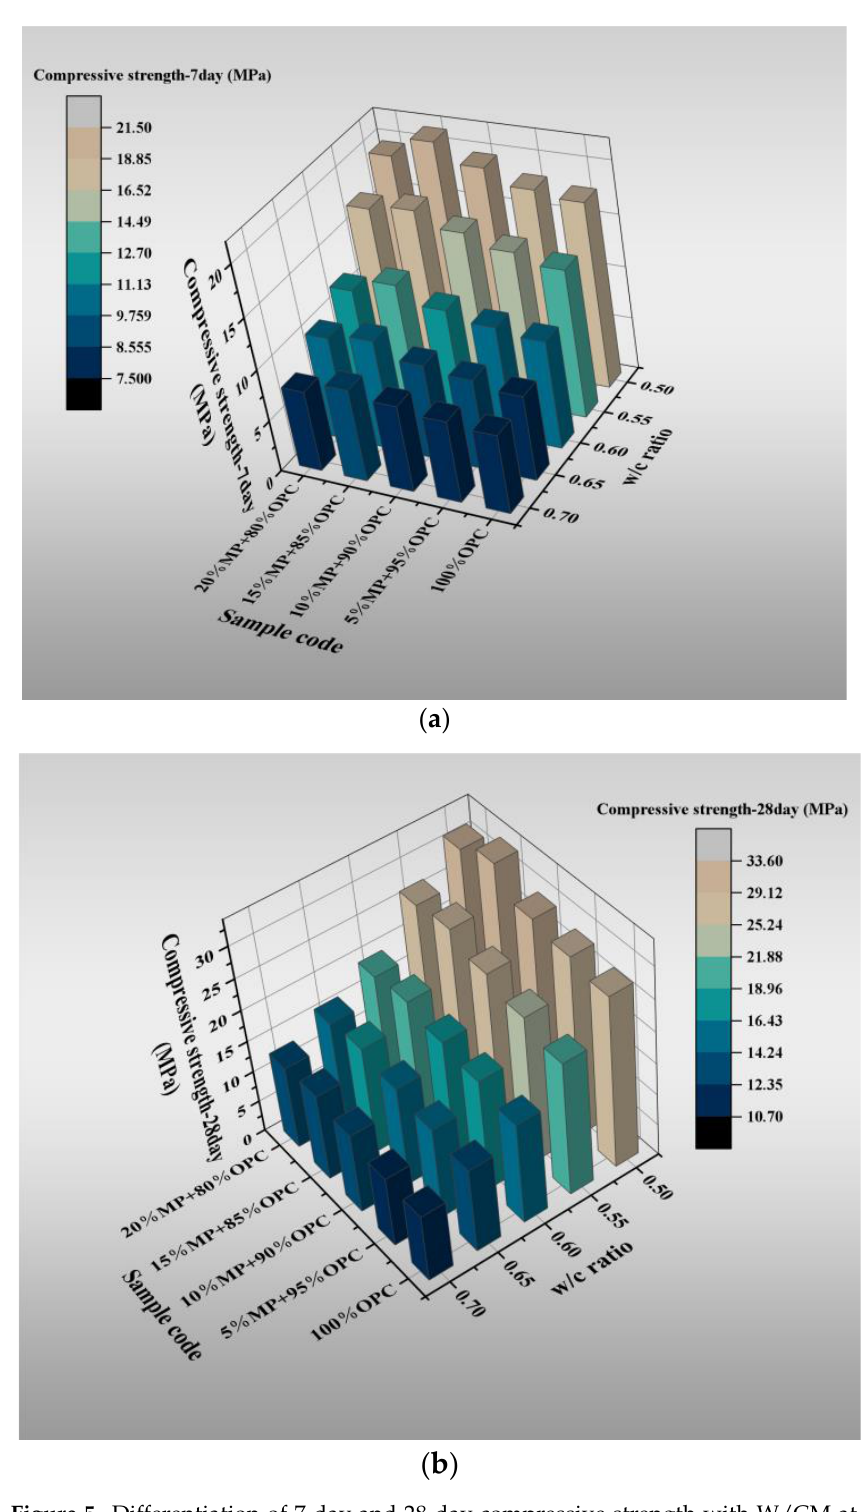
Figure 5. Differentiation of 7-day and 28-day compressive strength with W/CM at different MP contents; ( a ) 7 days, ( b ) 28 days . Table 3. Variation of 7-day and 28-day compressive strength with W/CM at various MP contents.